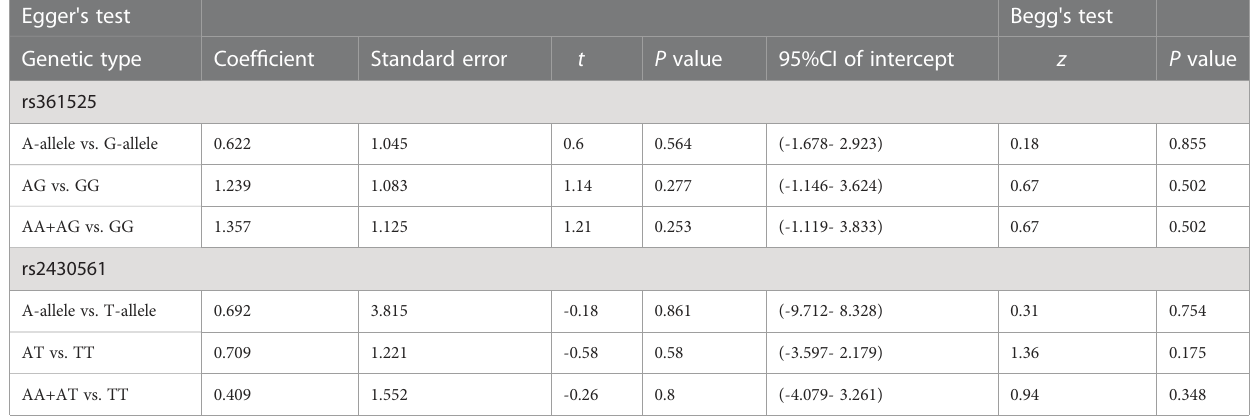
TABLE 3 Publication bias tests (Begg ’ s funnel plot and Egger ’ s test for publication bias test) for TNF- a and IFN- g genes polymorphisms. Egger's test Begg's